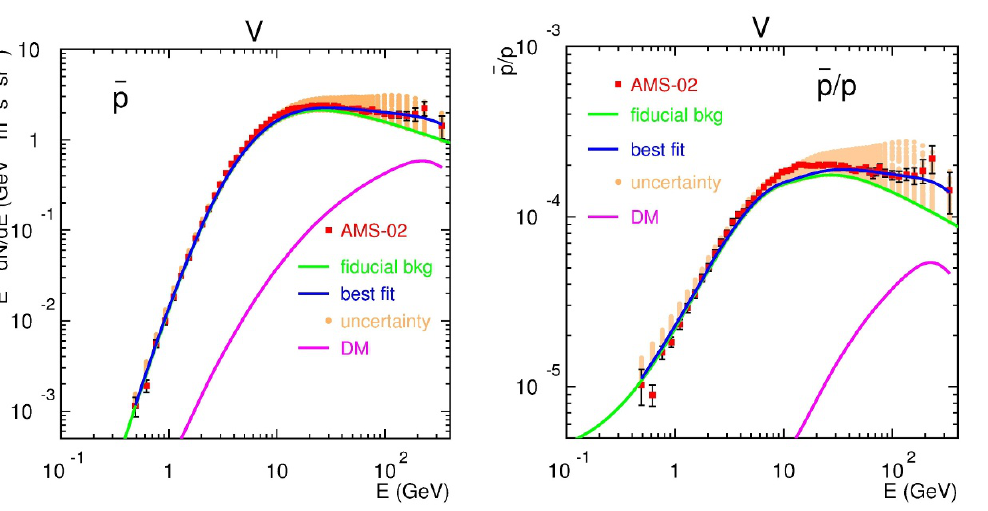
Figure 4 . Antiproton (cid:13)ux (left) and antiproton-to-proton ratio (right) observed by AMS-02 (red dots and dark error bars) in the simpli(cid:12)ed dark matter model V